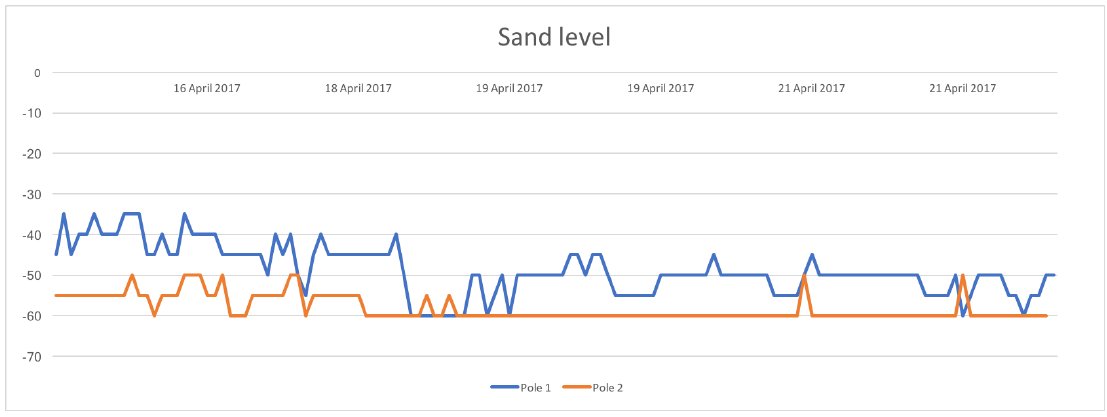
Figure 8. Sand level variation trends measured by the two